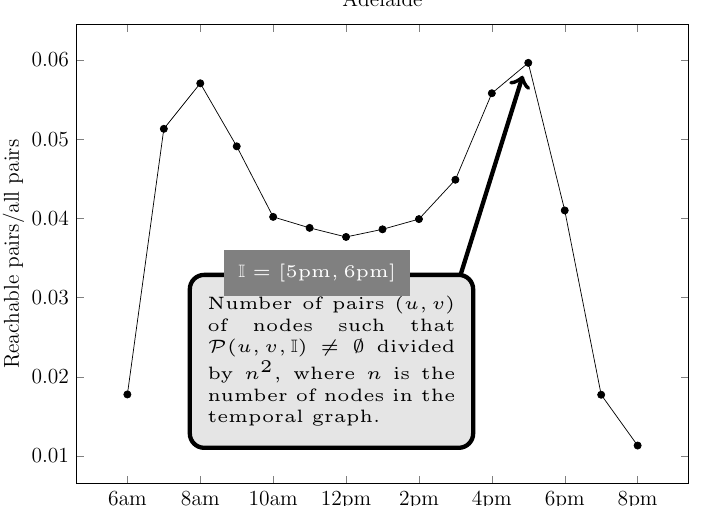
Figure 5. The reachability diagram of the public transport network of the city of Adelaide, in which the interval between 6:00 a.m. and 9:00 p.m. has been split into 15 intervals of one hour